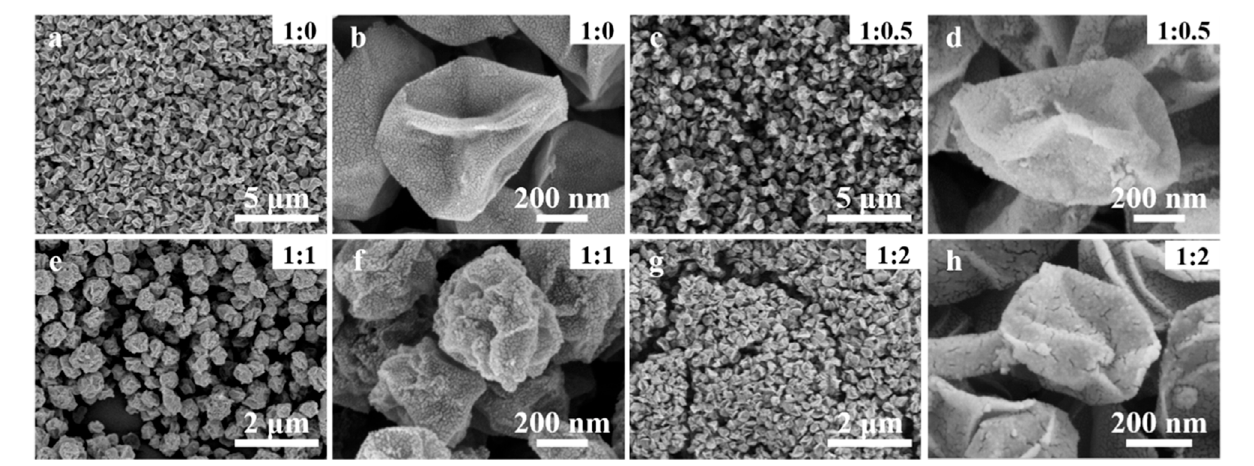
FIGURE 2 | SEM images of the printed hybrid Ti 3 C 2 T x /C nanospheres with different mass ratios of MXene and carbon nanoparticles. (A,B) Pristine MXene nanospheres; (C,D) hybridMXenenanosphereswithmassratioof1:0.5; (E,F) hybridMXenenanosphereswithmassratioof1:1; (G,H) hybridMXenenanosphereswith mass ratio of 1:2.